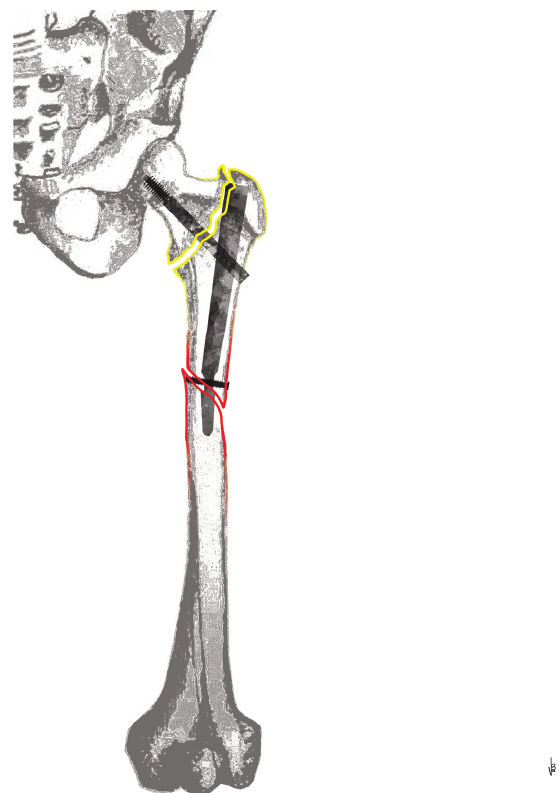
Figure 5: A drawing representing a BO2n